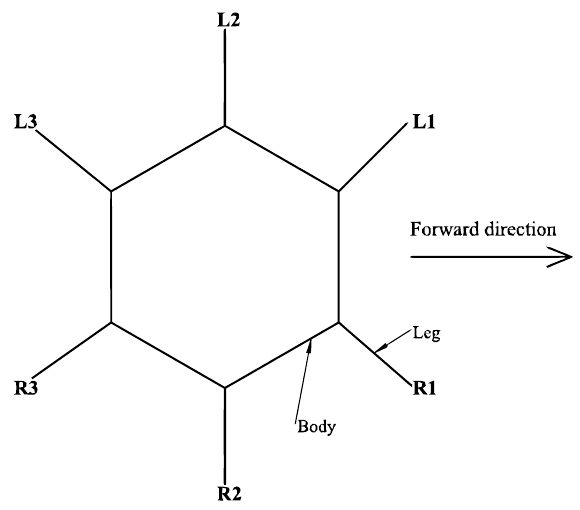
Figure 8. Gait analysis model.